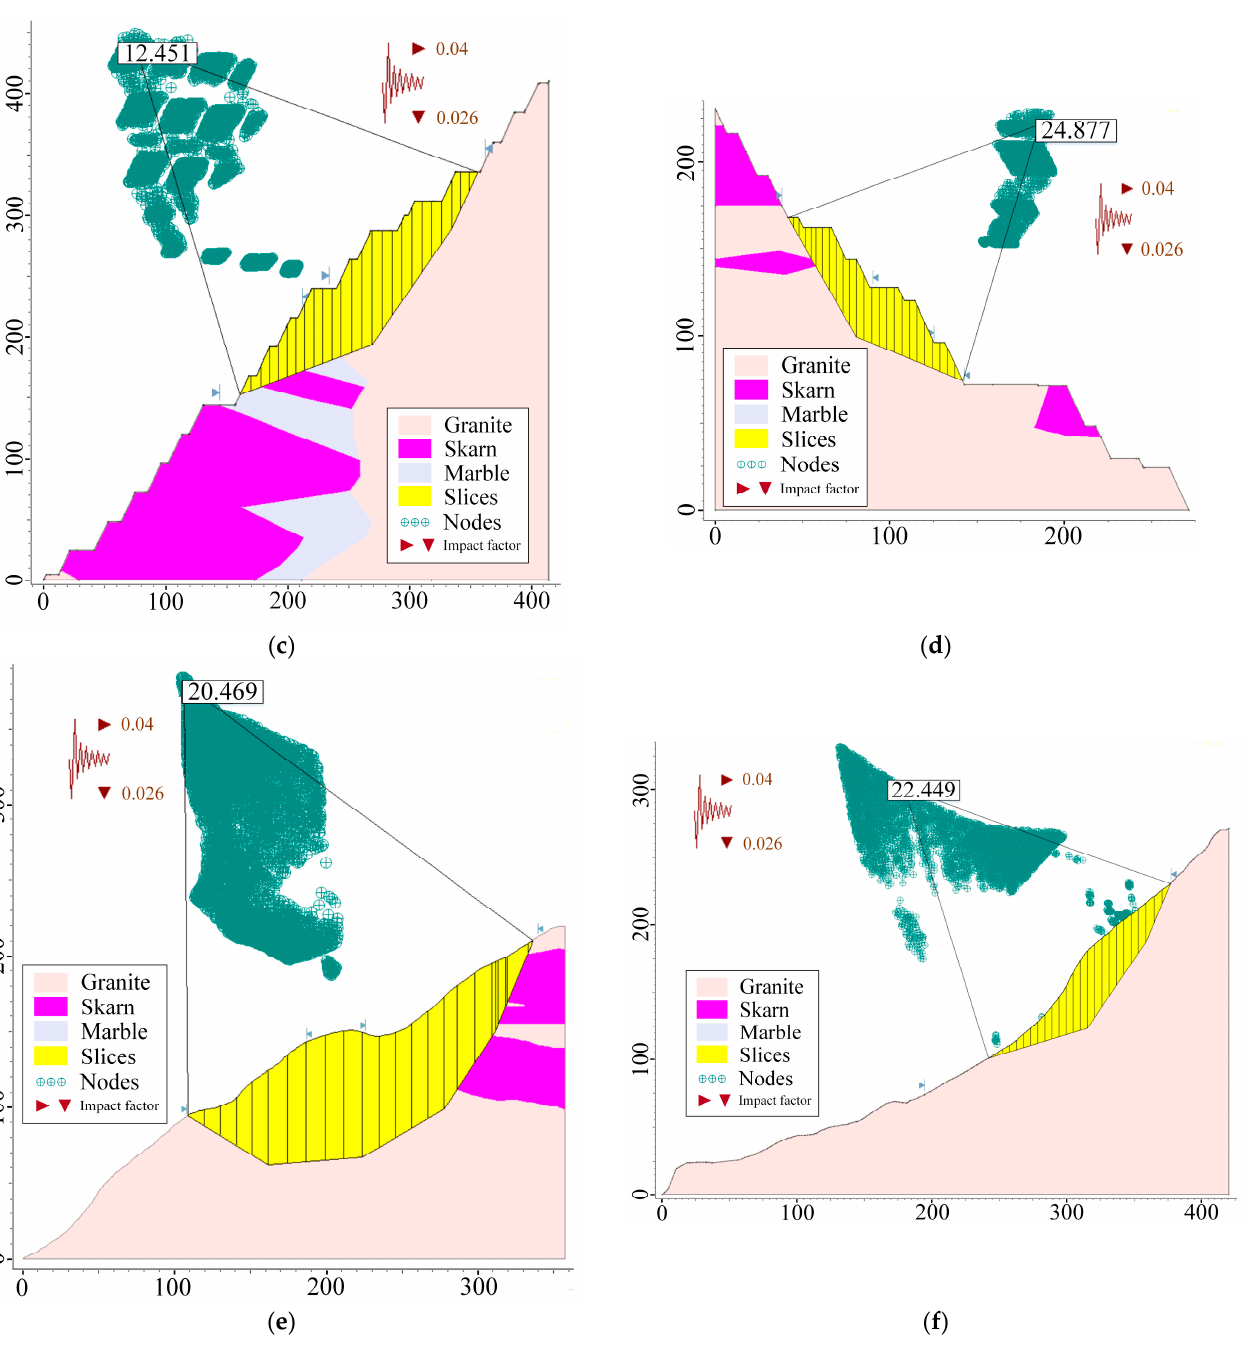
Figure 9. Calculation results of the limit equilibrium method (self ‐ weight + seismic force): ( a ) R1; ( b )